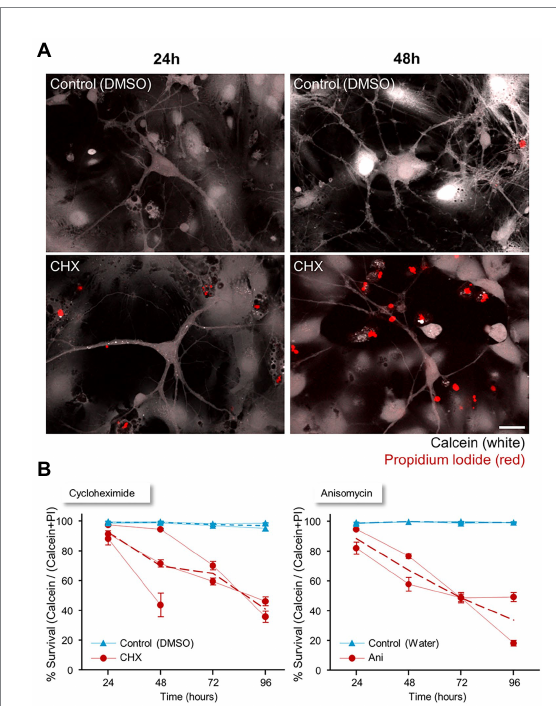
FIGURE 2 Timeline of neuronal survival following protein synthesis inhibitor treatment. (A) Two to 2.5 weeks after plating, cortical neurons were treated with cycloheximide (CHX), anisomycin (ANI), or carrier solution (0.1% DMSO in cell culture media, or 0.3% water) for a range of durations (24, 48, 72, or 96 hours). The cells were loaded with Calcein-AM (2 μ M; 30 min), and Propidium Iodide (2.5 μ M) was added immediately before imaging. The number of dead (PI-